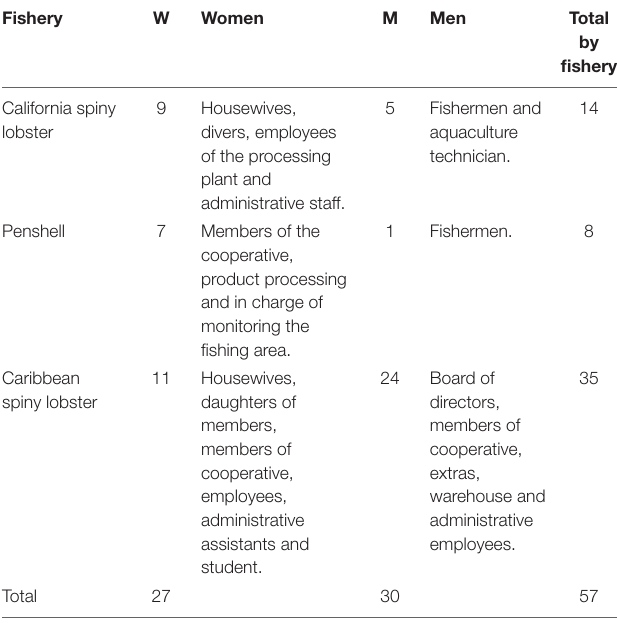
TABLE 1 | Individuals involved in the participatory